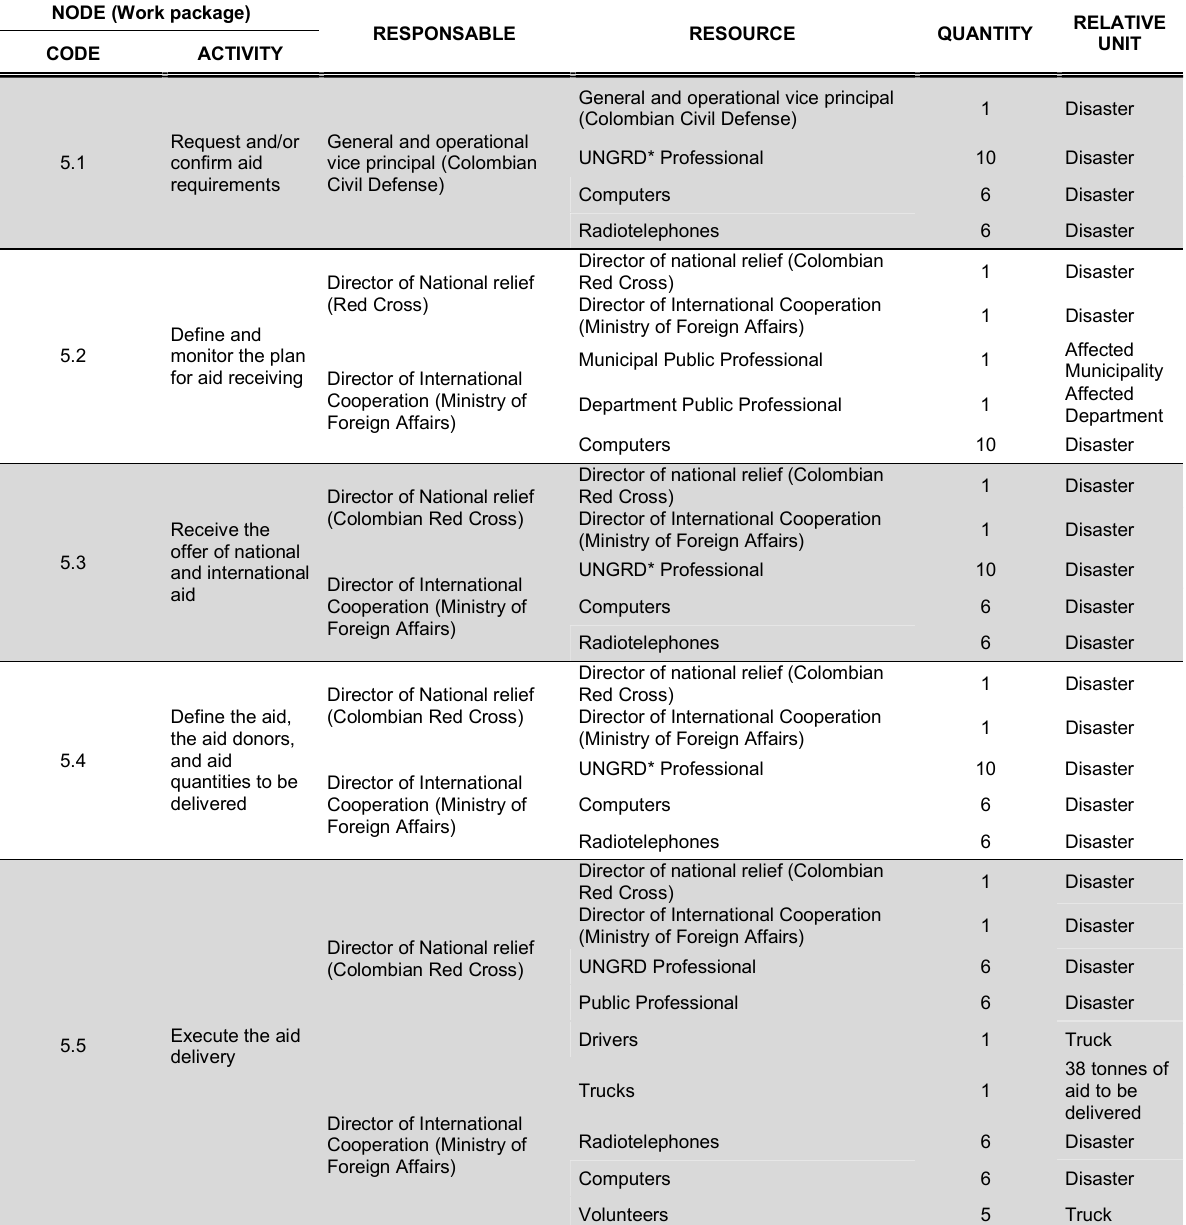
Resources matrix of Colombian Aid Management